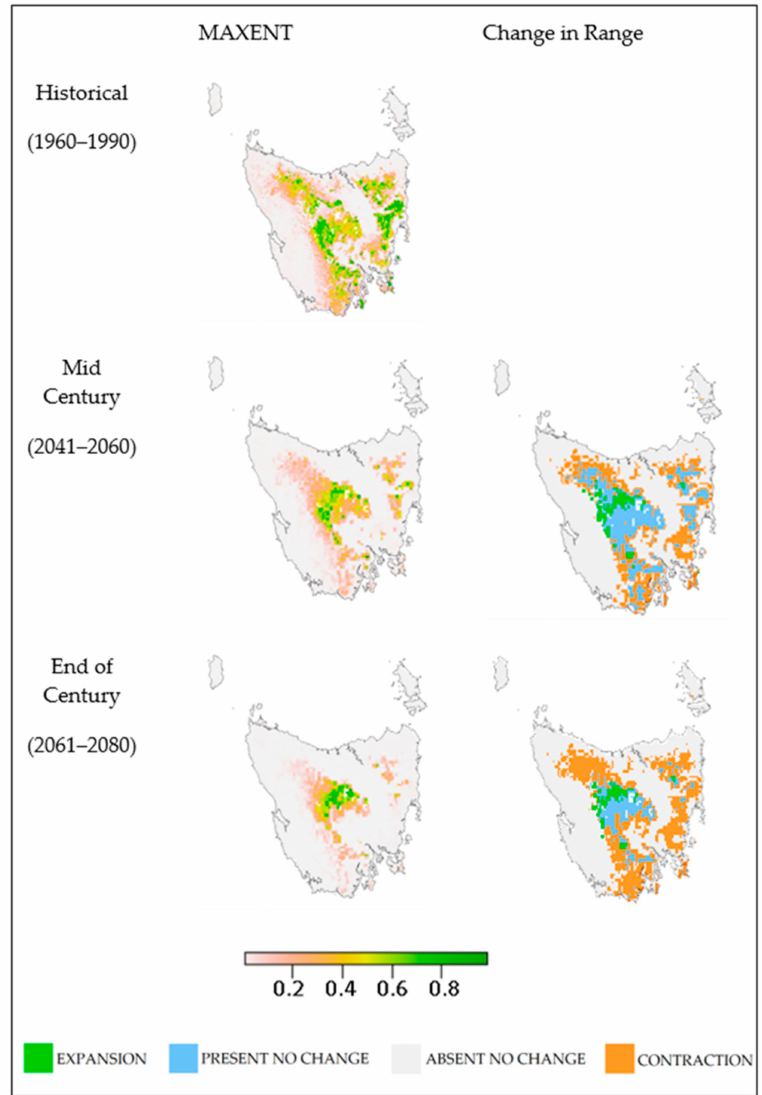
Figure 4. Environmental suitability for E. delegatensis in Tasmania, shown as a probability of occur- rence, and change in species range projected under historical (1960–1990) and future climates for mid (2041–2060) and end of century (2060–2081), as modelled by SDM Maxent and GCM